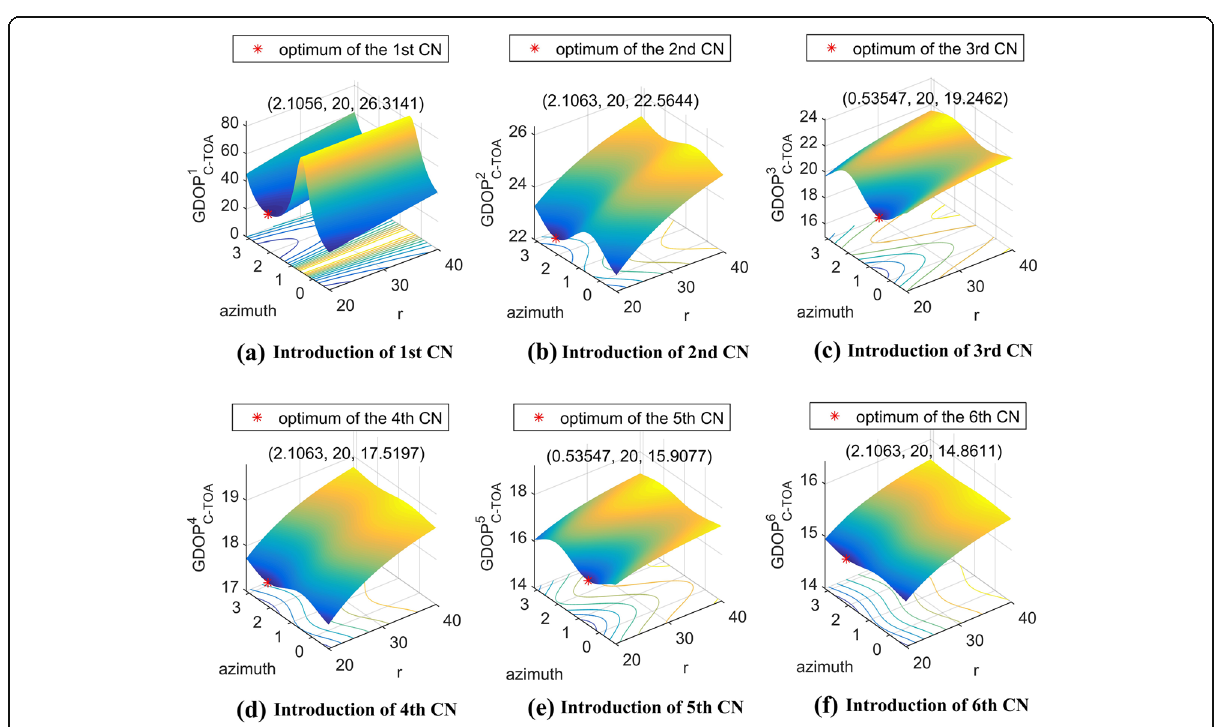
Fig. 5 Performance of partial exhaustive method towards AOA-based system in environment 1. a Introduction of the first CN. b Introduction of the second CN. c Introduction of the third CN. d Introduction of the fourth CN. e Introduction of fifth CN. f Introduction of sixth